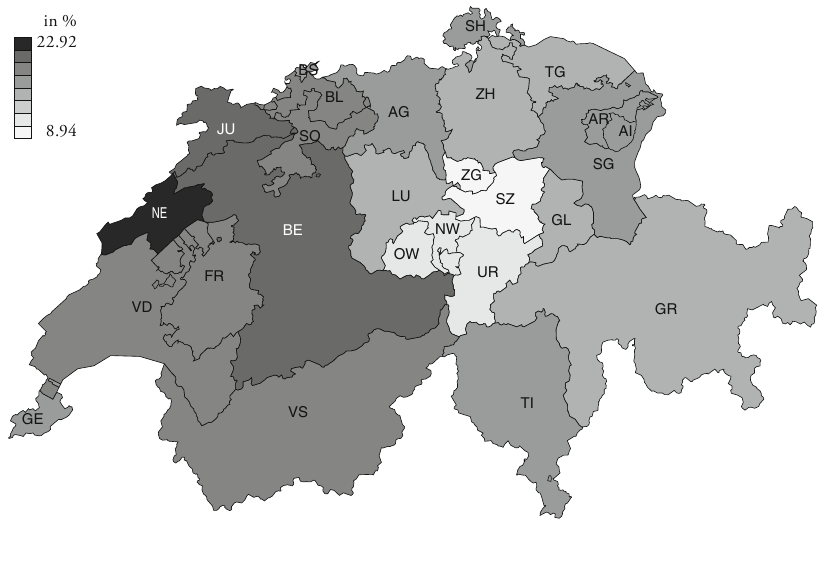
Figure 3: Consolidated cantonal (cid:2) municipal effective average tax rate across Swiss cantons in 2014 for a married couple with two children and top-1% income. Average across municipalities weighted by the number of